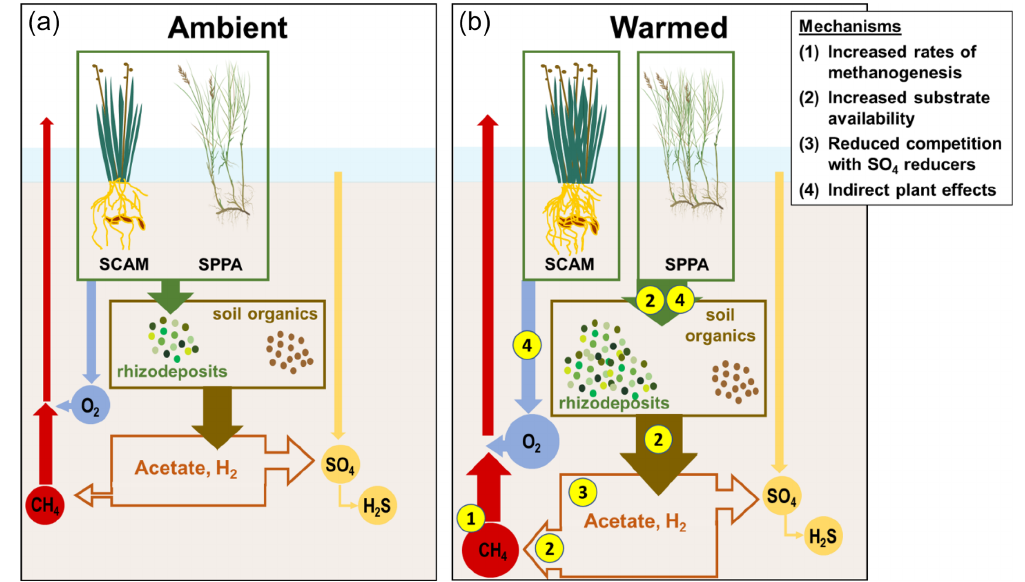
Figure 7. Schematic of mechanisms driving enhanced CH 4 emissions in response to warming. SCAM: Schoenoplectus americanus . SPPA: Spartina patens . (a) Processes under ambient conditions. Plants add organic compounds to the soil, which are transformed into other low- molecular-weight organic compounds. This pool, and processed soil organic matter, support terminal respiration processes dominated by SO 4 reduction over CH 4 production in organic-rich brackish marsh soils. Plants also transport O 2 , which supports oxidation of a fraction of the CH 4 before it can be transported out of the soil. (b) Processes under warmed conditions. (1) Rates of CH 4 production increase more than rates of CH 4 oxidation. (2) Substrate availability increases as plants add more rhizodeposits and organic matter is more rapidly fermented to low-molecular-weight organic compounds and H 2 . (3) The pool of electron donors available to methanogens increases as SO 4 reducers become SO 4 limited. (4) The dominant plant species have different effects on these processes, with S. americanus driving a net increase in O 2 transport and S. patens driving a net increase in